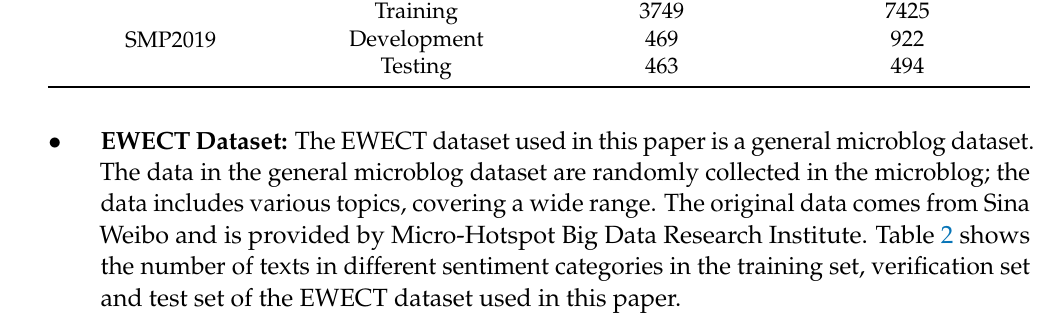
Table 2. The proportions of the implicit experimental dataset for EWECT.